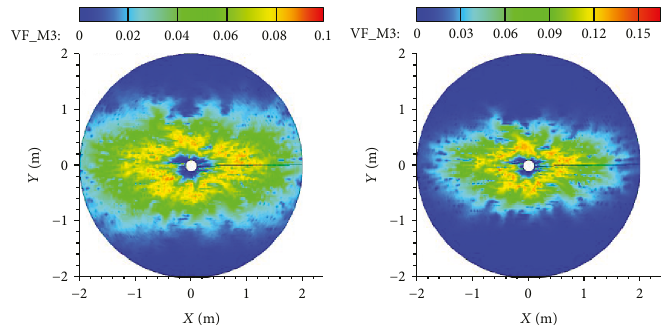
Figure 16: Silica precipitation distribution in two layers.